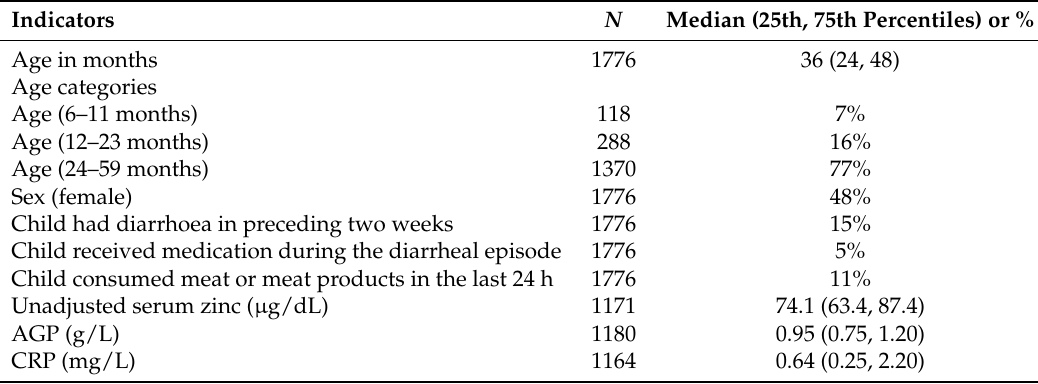
Table 1. Characteristics of study participants (children under five years) from the Ethiopian National Micronutrient Survey